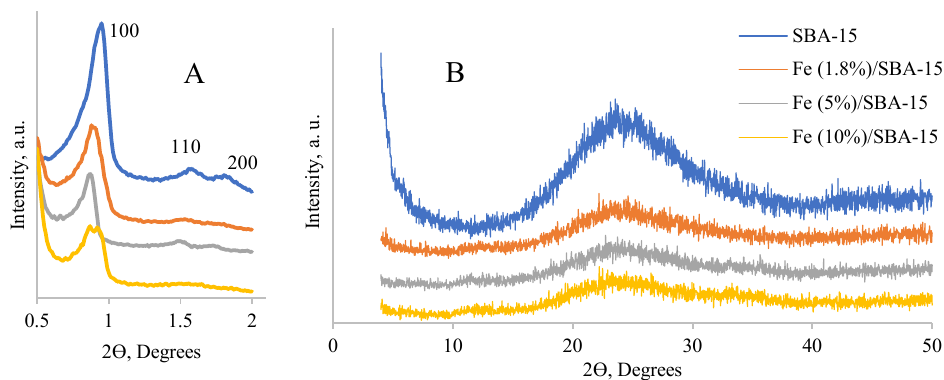
Fig. 1. SXRD (A) and WXRD (B) patterns of SBA-15, Fe (1.8 %)/SBA-15, Fe (5 %)/SBA-15, Fe (10